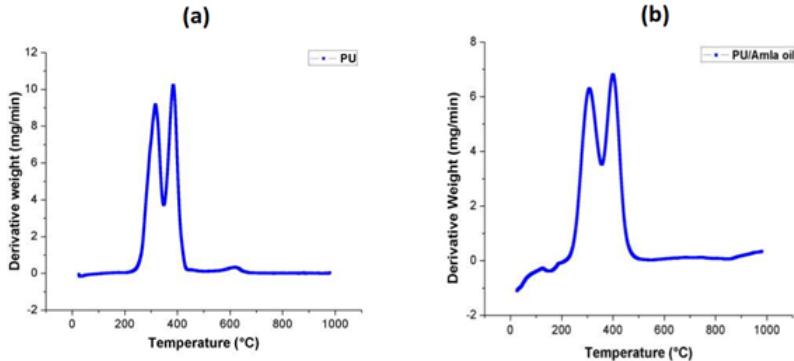
Figure 5. Weight residue percentage of (a) PU membrane (b) PU/Amla oil